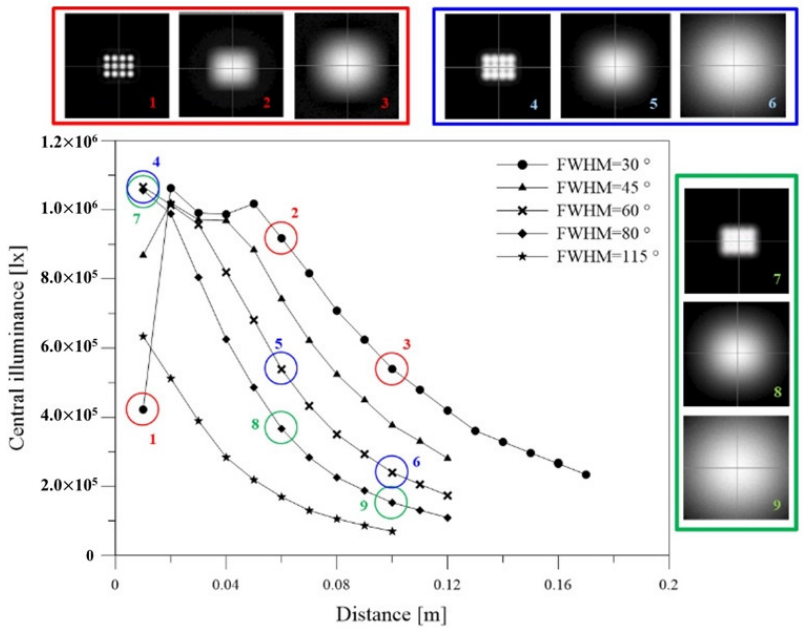
Figure 7. Central illumination location patterns in solid array. Red, FWHM: 30 ° ; blue, FWHM: 60 ° ; green, FWHM: 80 ° .